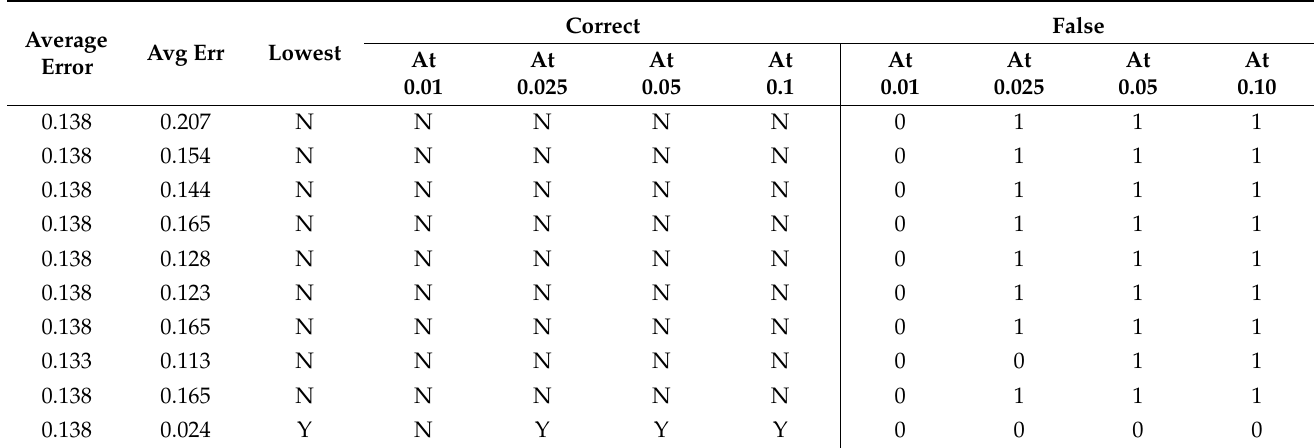
Table A215. Set 3, trials 31–40 summary data (all 0.5 PR values).